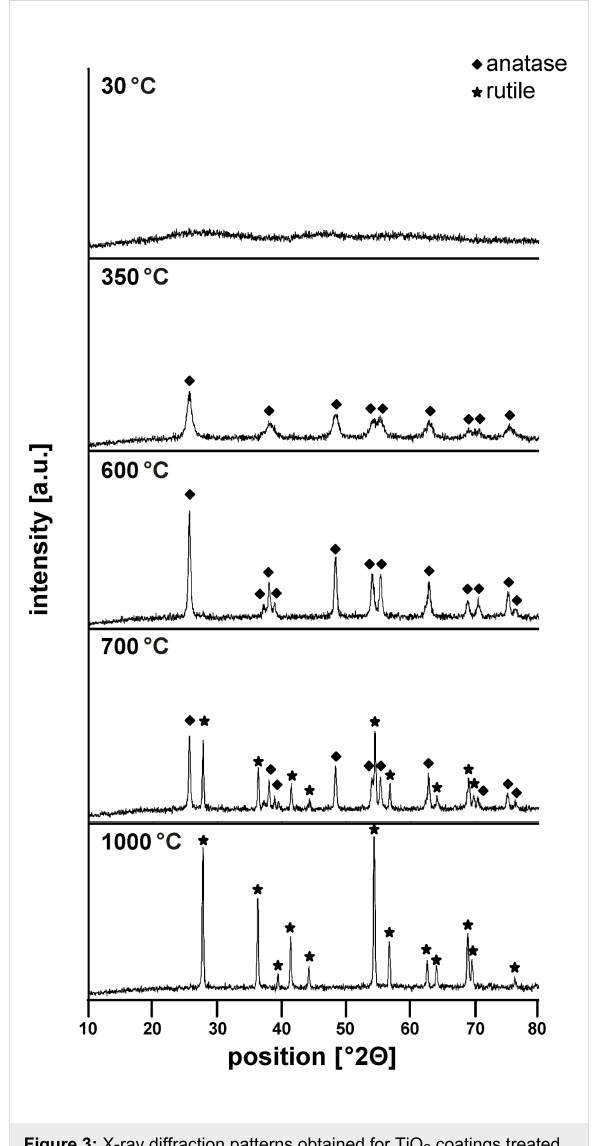
Figure 3: X-ray diffraction patterns obtained for TiO 2 coatings treated at different temperatures as indicated in the figure.